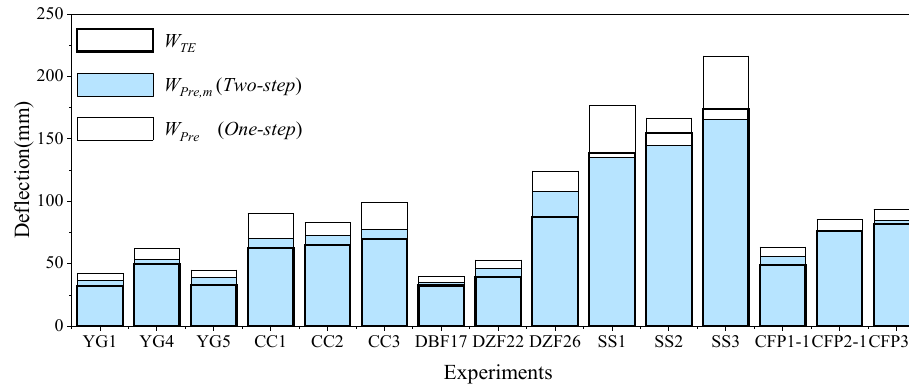
Figure 10. Maximum deflection at the impact point.